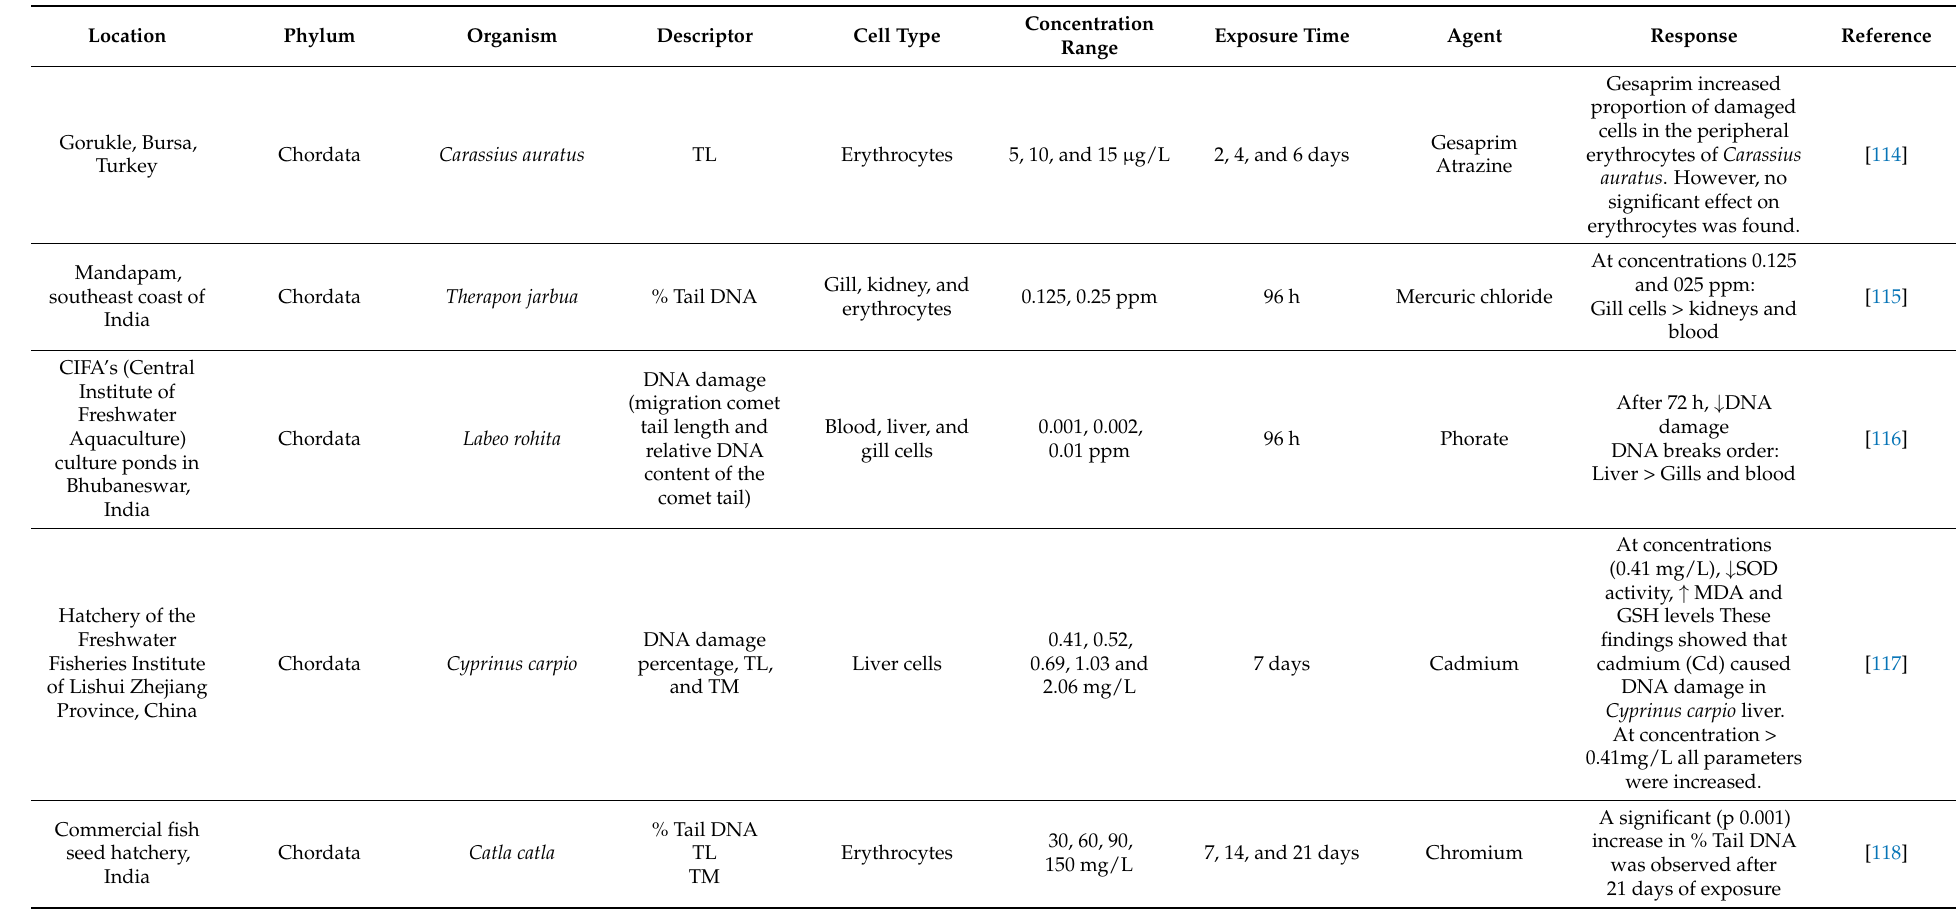
Table 3. Comet test evaluation of DNA damage in aquatic